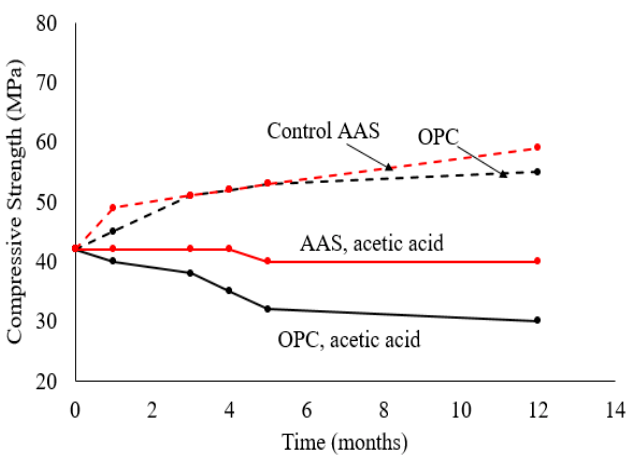
Figure 4. Compressive strength development of mortar with AAS or OPC binders in acetic acid compared to immersion in water [56].